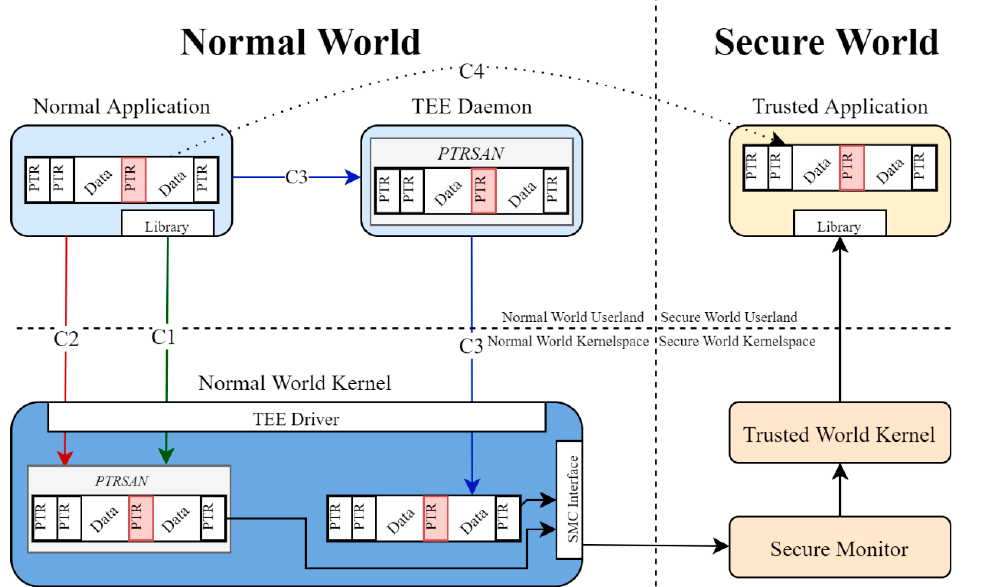
Figure 11. Boomerang attack architecture.